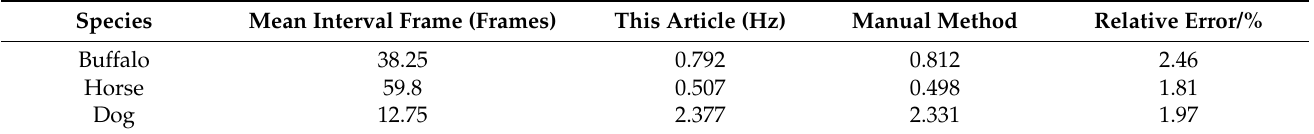
Table 5. Gait frequency of buffalo, horse, and dog.